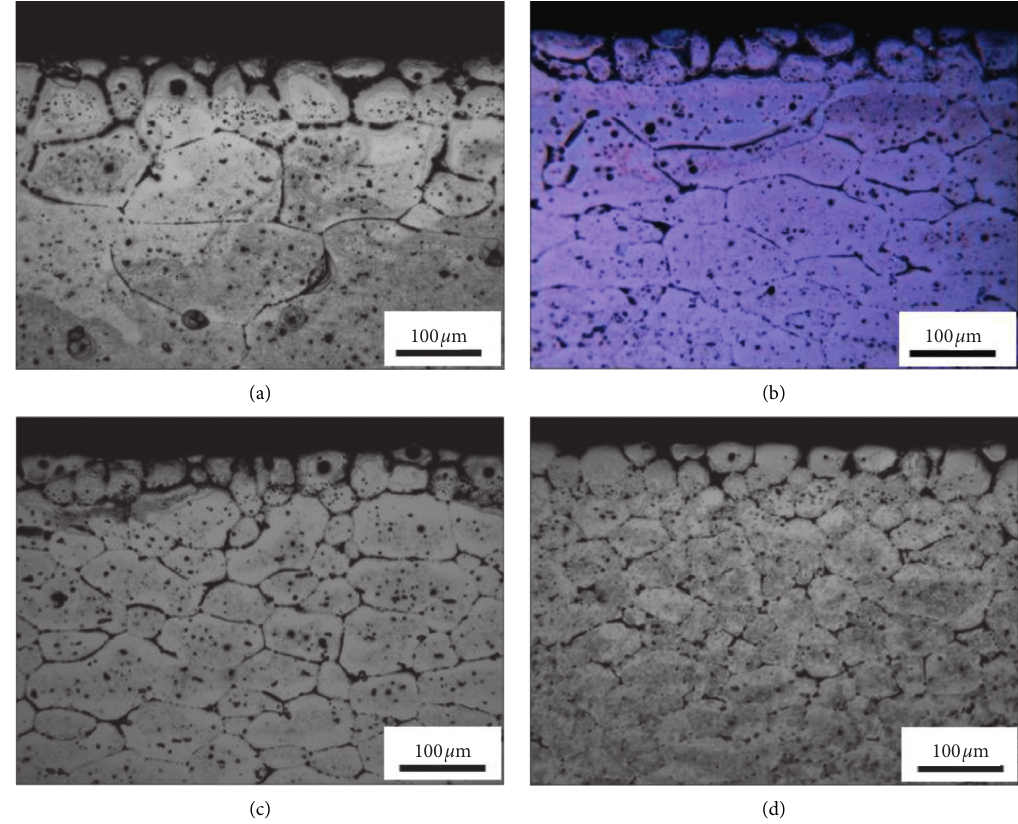
Figure 11: Cross-sectional microstructures of the brazed specimen annealed at 360 ° C and rolled to (a) 10%, (b) 20%, (c) 30%, and (d)